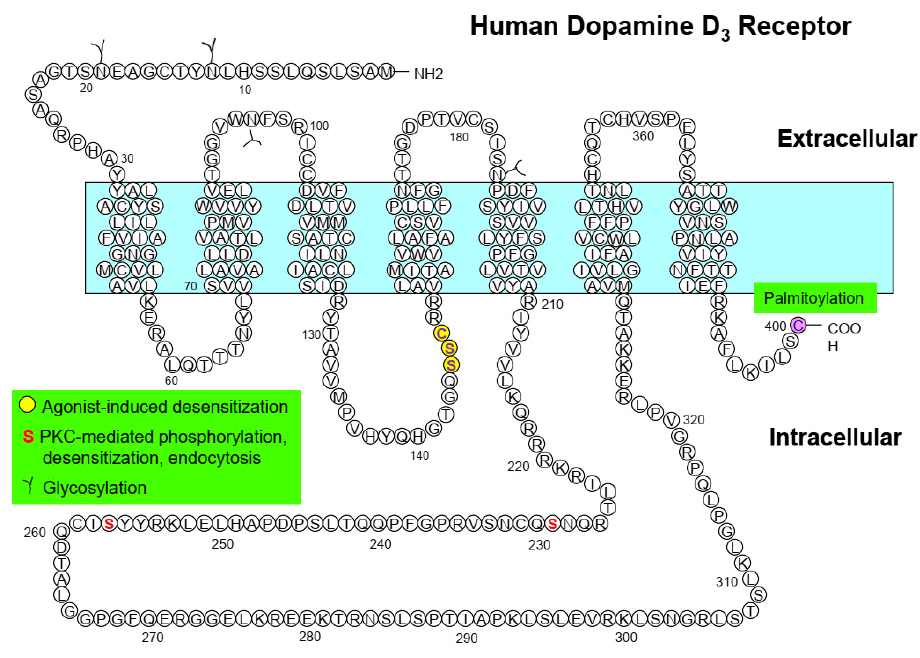
Figure 2. Major pos tt ranslational modi fi cation sites of dopamine D 3 receptor and their functional roles. Circles filled with yellow indicate the amino acids responsible for agonist-induced desensitiza- tion; the two S residues highlighted in red indicate PKC-mediated regulatory processes.